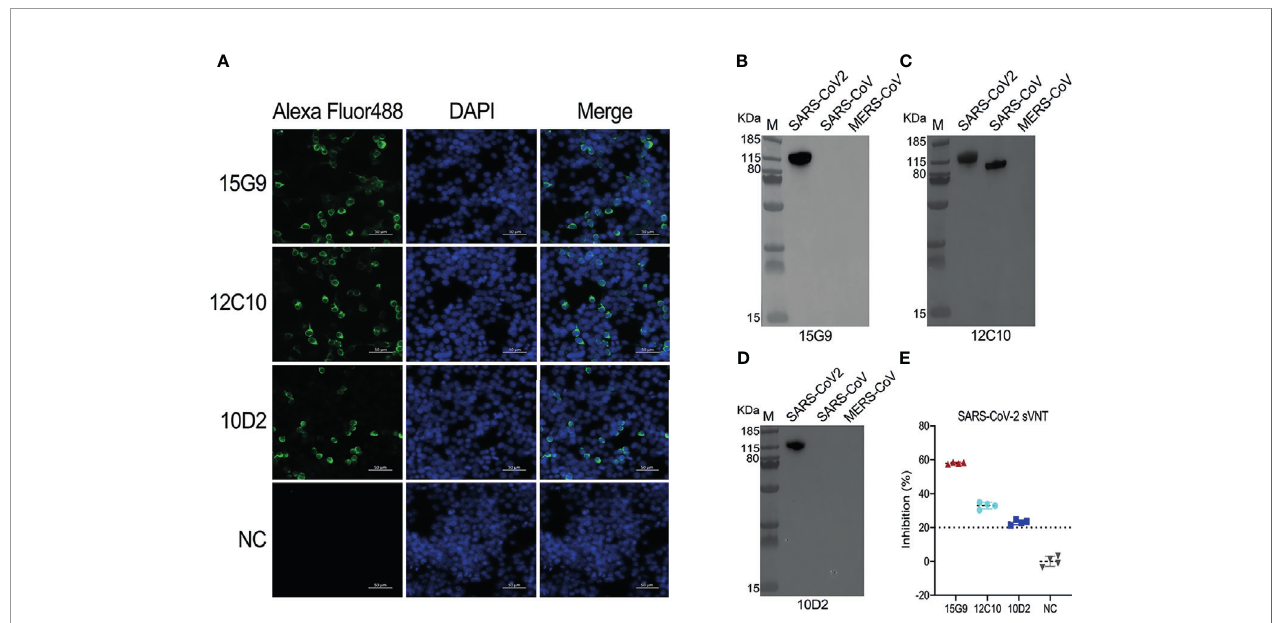
FIGURE 3 | Characterization of the isolated mAbs (15G9, 12C10, 10D2). (A) Binding of the mAbs with SARS-CoV-2 S protein expressed in HEK293T cells. MAbs anti-SARS-CoV-2 S protein (green). Nuclei (blue). NC, Negative control. Scale bars, 50 m m. (B – D) The reactivity of mAbs with S1 proteins of SARS-CoV-2, SARS- CoV and MERS-CoV was measured by western blotting. (E) The neutralization capacity of the mAbs. NC, Negative